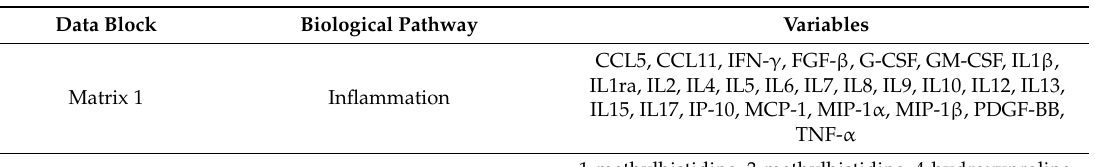
Table 2. Composition of the multi-block dataset used for Sequential and Orthogonalized Covariance Selection (SO-CovSel)